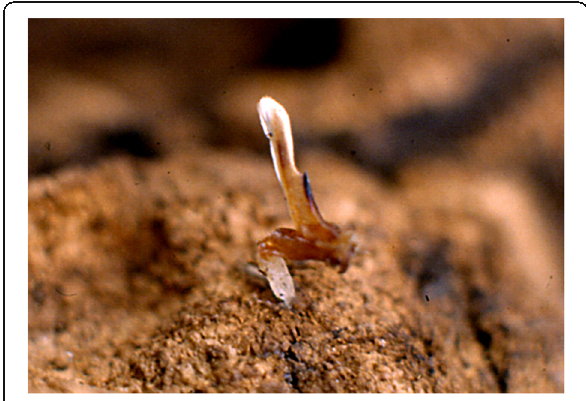
Fig. 1 Deposited spermatophore of Opisthacanthus cayaporum (Brazilian hormurid) in a piece of bark, after the parturition